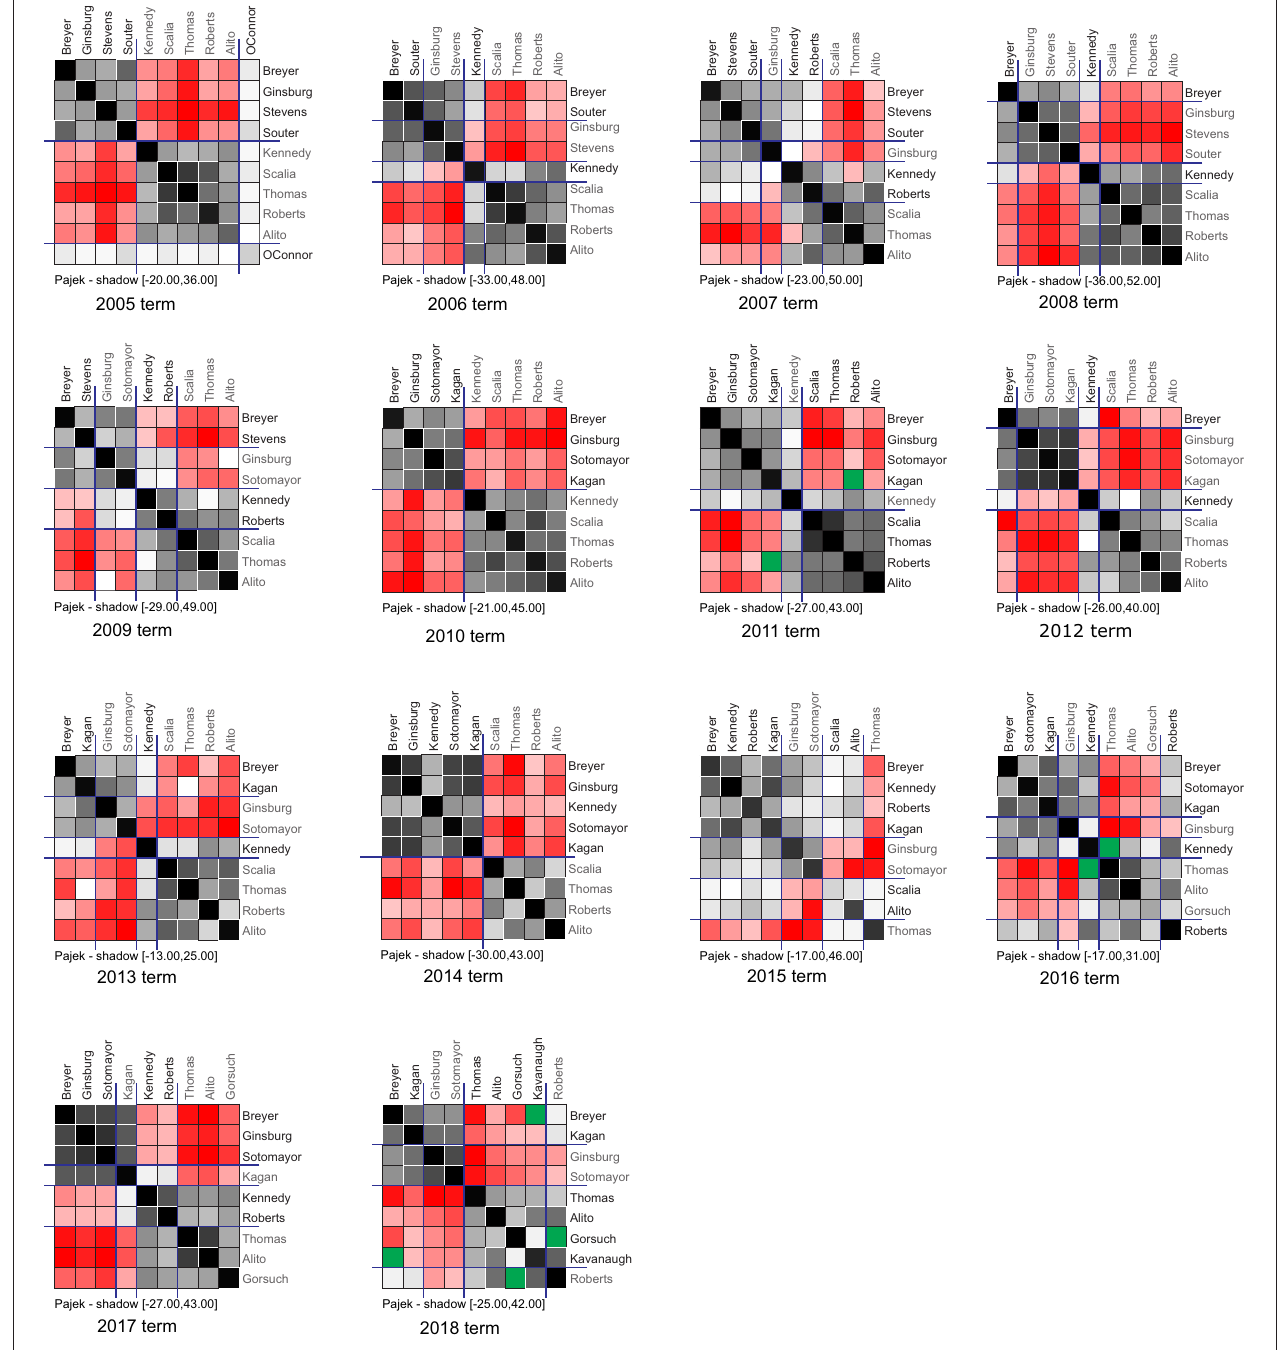
FIGURE 3 | Relaxed structural balance partitions of the first 14 terms of the Roberts Court. Black and gray squares represent net levels of agreements between pairs of justices. Red and pink squares represent net levels of disagreements between pairs of justices. Green squares represent the value 0. Diagonal squares are necessarily black as, trivially, justices always agree with themselves. The largest positive value is represented by black cell, smaller positive values are represented by grayscale linearly descending. The same is true for negative values: the largest negative value is represented by true red, then red colors becomes less red when negative values are smaller. For the 2005 term, for example, the value 36 (the highest net number of agreements) is represented with true black and the value − 20 (the highest net number of disagreements) with true red. The value of the criterion function for each of these years is 0 (except for 2007).